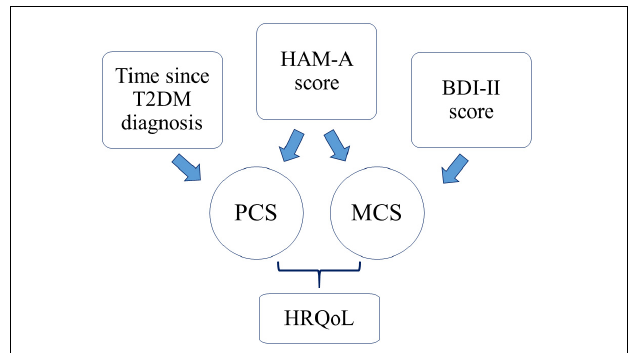
FIGURE 3 | Main determinants of HRQoL in T2DM